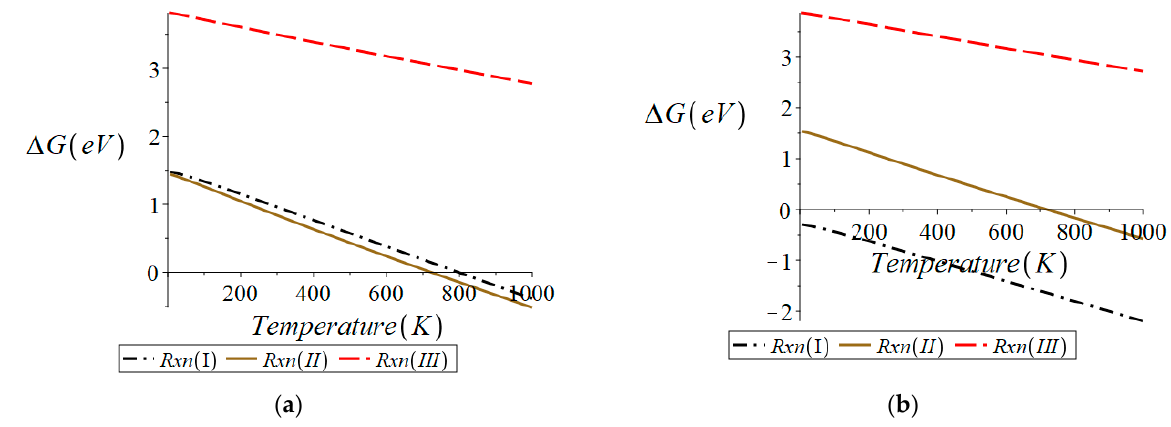
Figure 3. Surface of cubic BCF8515 for ( a ) surface with no oxygen vacancy defects, ( b ) surface with 1 oxygen vacancy defect. Plots were generated in Maple TM .